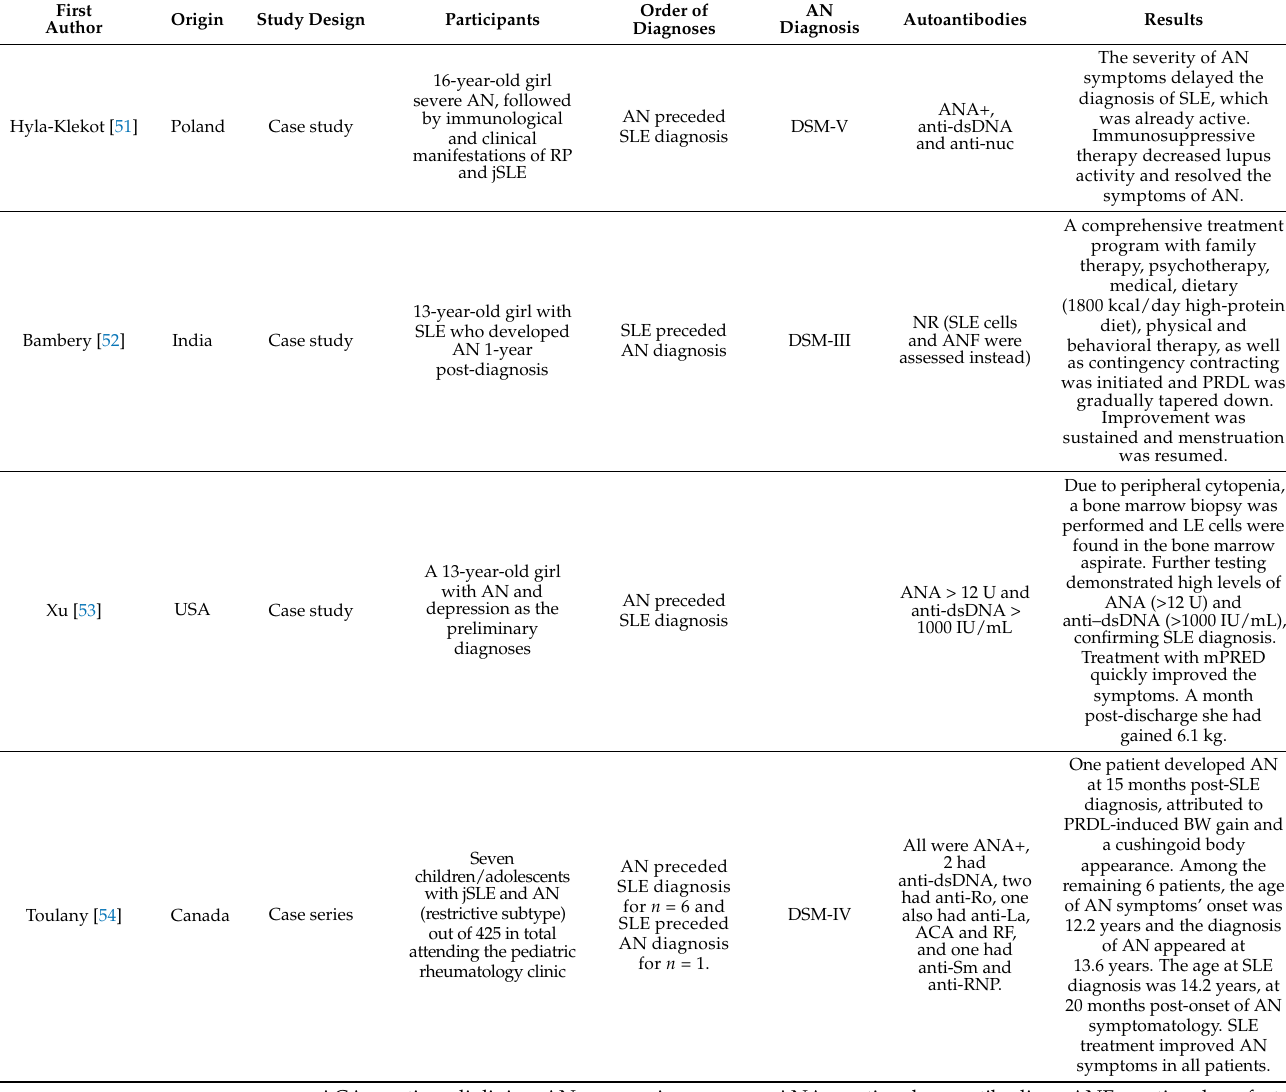
Table 1. Case reports/series published in the literature describing pediatric patients with SLE and